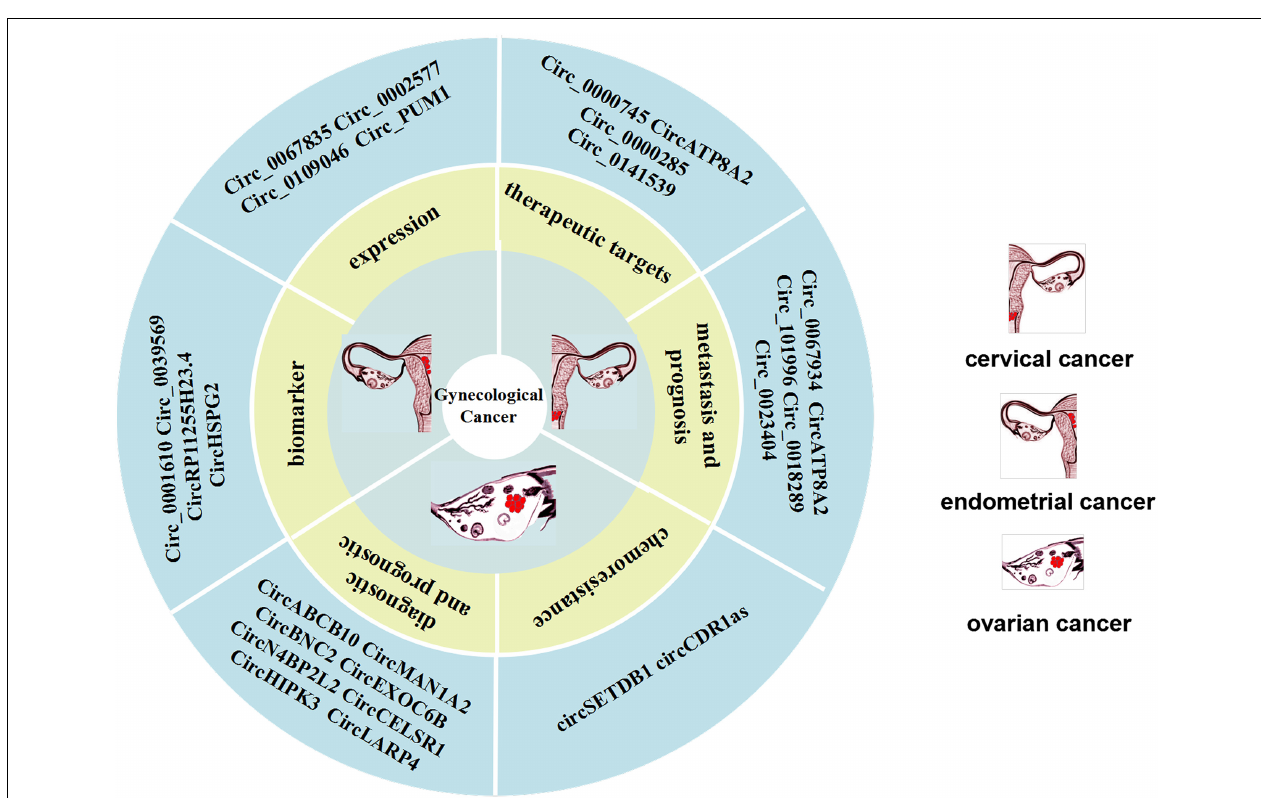
FIGURE 3 | CircRNAs can be used as biomarkers of cervical cancer (CC) metastasis and prognosis as well as potential therapeutic targets. CircRNAs can be used as biomarkers of ovarian cancer (OC) diagnosis and prognosis, as well as chemoresistance. Expression of CircRNAs are expressed in endometrial cancer (EC) and are potential biomarkers for endometrial